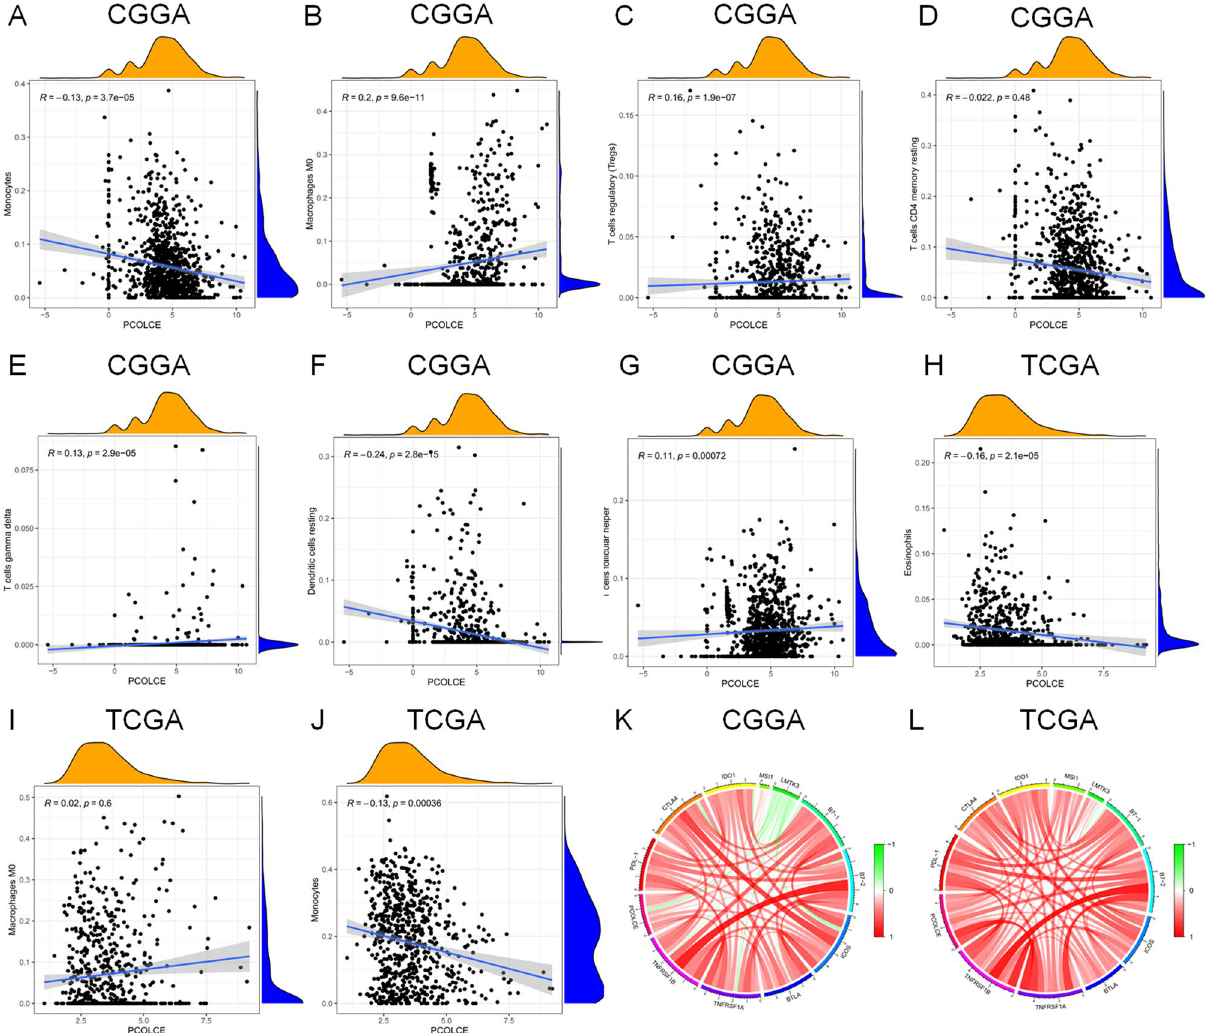
Figure 8. Correlation analysis between different PCOLCE expression groups and 22 types of immune cells in glioma using the CGGA and TCGA databases. PCOLCE expression was positively associated with ( B ) M0 macrophages, ( C ) regulatory T cells, ( E ) γδ T cells, ( G ) follicular helper T cells in CGGA and negatively correlated with ( A ) monocytes, ( D ) resting memory CD4 + T cells, and ( F ) resting dendritic cells. ( I ) M0 macrophages were positively correlated with PCOLCE expression in TCGA. PCOLCE expression was negatively associated with ( H ) monocytes and ( J ) eosinophils. The circle diagram showed that PCOLCE were positively correlated with the immune checkpoints PDL-1, CTLA-4, IDO1, MSI1, LMTK3, B7-1, B7-2, ICOS, BTLA, TNFRSF1A, and TNFRSF1B in the ( K ) CGGA and ( L ) TCGA been shown to promote glioma growth and invasion 35 . Due to the significant negative correlation between M0 macrophages, monocytes, and OS, we speculate that M0 macrophages play an important role in glioma develop- ment after monocyte transformation. Another important finding was that PCOLCE expression was associated with multiple levels of immune infiltration in gliomas. They were significantly correlated with dendritic cells, CD4 + T cells, macrophages, neutrophils, and B cells in LGG; high PCOLCE expression was also correlated with dendritic cells and GBM purity. Our study found that high PCOLCE expression is associated with poor prognosis in patients with glioma, which may be due to suppression of tumor-associated immune cells. Additionally, some of these immune cells in patients with LGG influence prognosis and correlate with PCOLCE expression. However, these same results were not found in GBM, suggesting differences in PCOLCE function between LGG and GBM. Therefore, further mechanistic studies are required. However, glioma tumors are highly heterogenous and include not only the glioma cells, but also the glioma- associated non-neoplastic cells, such as stromal cells and immune cells 36 .Although these non-tumor cells, par- ticularly immune cells, act as pivotal players in glioma progression, the presence of these cells dilutes the purity of glioma cells 37,38 . Tumor and non-tumor cells cooperate with each other to maintain the delicate homeostasis of glioma initiation, malignant tumor progression, and therapeutic resistance 39,40 .Therefore, after adjusting the